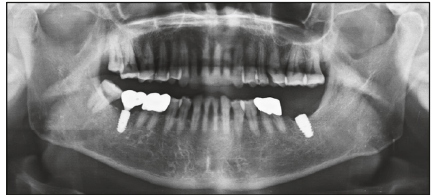
Figure 1: Preoperative radiographic view (panoramic X-ray image). Implantof#37areashowsthebrokenabutmentscrewofftheimplant fixture